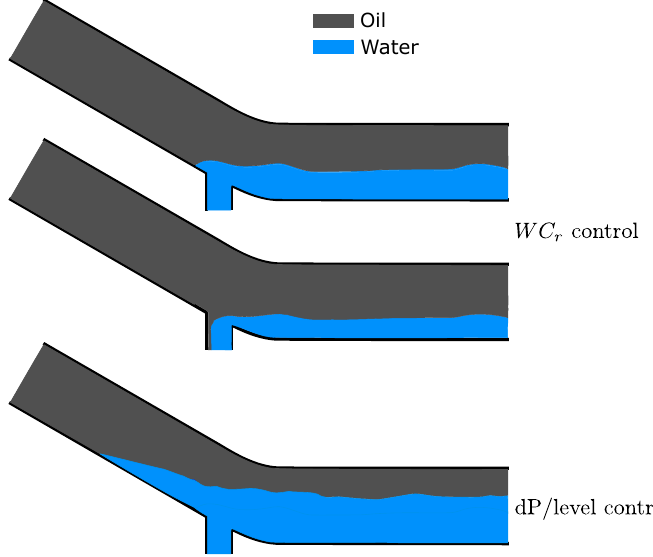
Figure 6. When controlling WC r directly, no buffer volume of water is present in the inclined section. Hence, oil breakthrough into the water outlet is more frequent when comparing to the dP/level